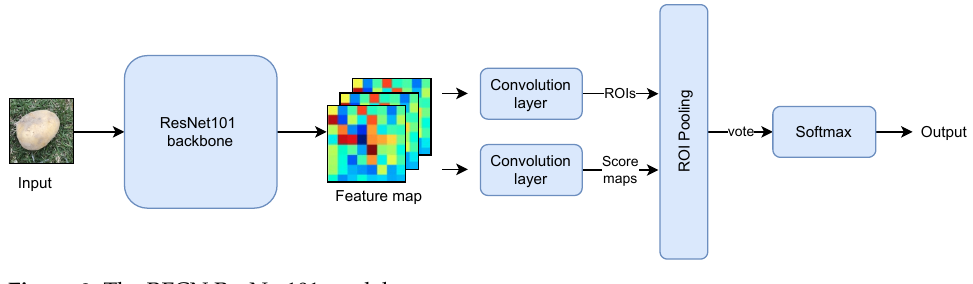
Figure 8. The RFCN ResNet101